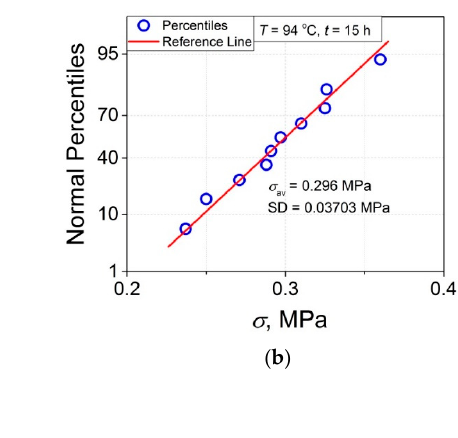
Figure 5. ( a ) Linear regression fit of the lap shear strength σ in Weibull’s coordinates; ( b ) normal probability plot; ( c ) probability density function (PDF) vs. σ fitted with a Gaussian function for an amorphous PET–PET interface self-bonded at T = 94 °C for t = 4 h.